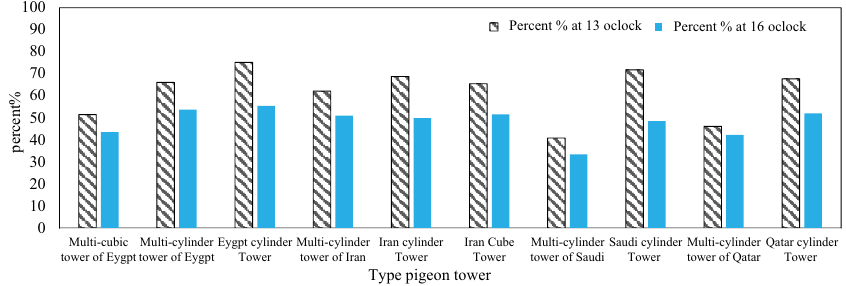
Figure 4. Total heat absorption in percentage by the surfaces of the pigeon towers